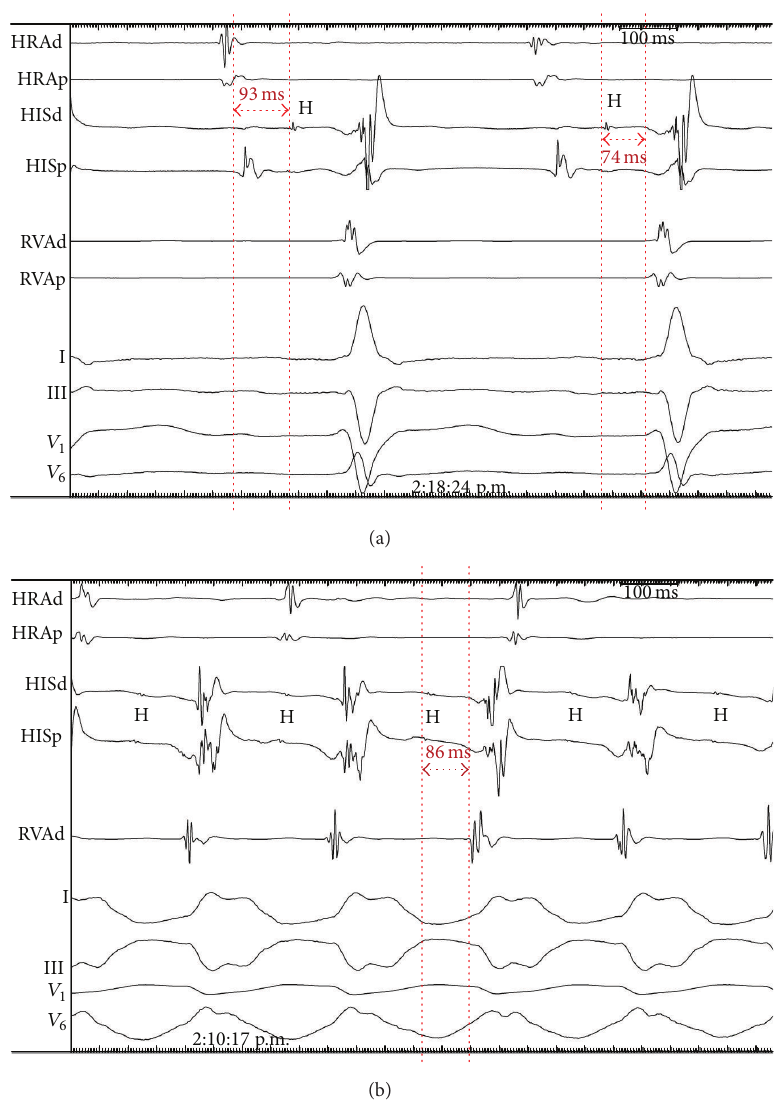
Figure 3: Results of electrophysiological investigation: (a) sinus rhythm; His bundle electrogram shows normal AH interval (93ms) and delayed conduction in His-Purkinje system (HV interval 74 ms); (b) Bundle branch reentrant ventricular tachycardia: VA dissociation points to localization of reentrant circle within ventricles; typical bundle branch reentrant tachycardia features are (1) His bundle potential (H) precedes QRS in every beat and (2) HV interval in LBBB-shaped tachycardia (86ms) is longer than HV interval on sinus rhythm. Tachycardia uses RBB as anterograde limb and LBB as retrograde limb of reentrant circuit; HRA, high right atrium; RVA, right ventricle apex; HIS, His bundle